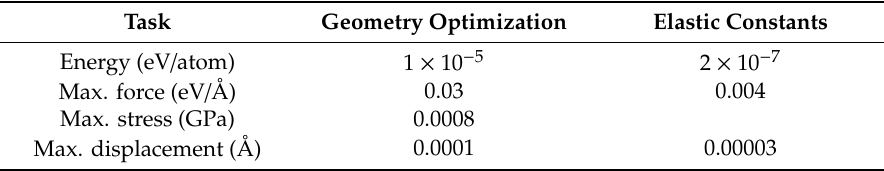
Table 1. Values of the convergence thresholds for each